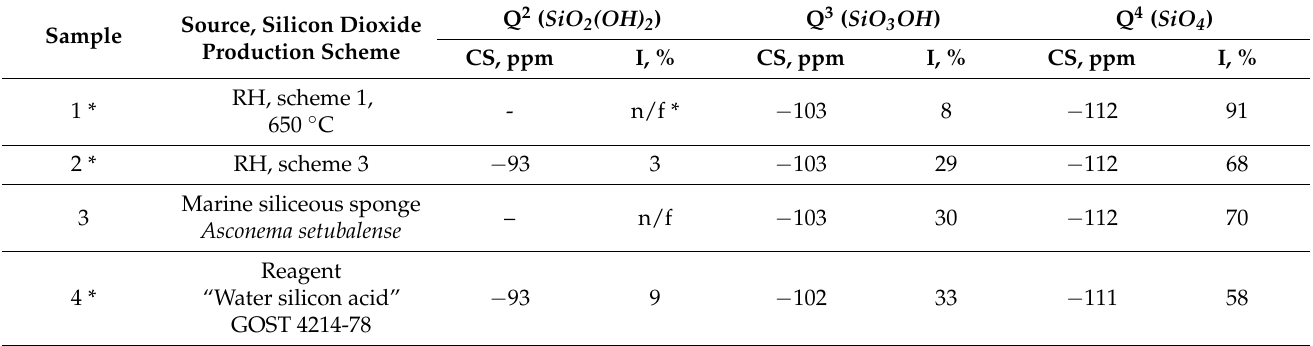
Figure 13. NMR 29 Si spectra: 1 and 2 are silica samples obtained from rice husk via thermal treatment and chemical precipitation correspondingly; 3—according to Table 1; 4—reagent silicic acid aqueous GOST 4214-78. Table 4. Values of chemical shift (CS) and concentration (I) of silicon